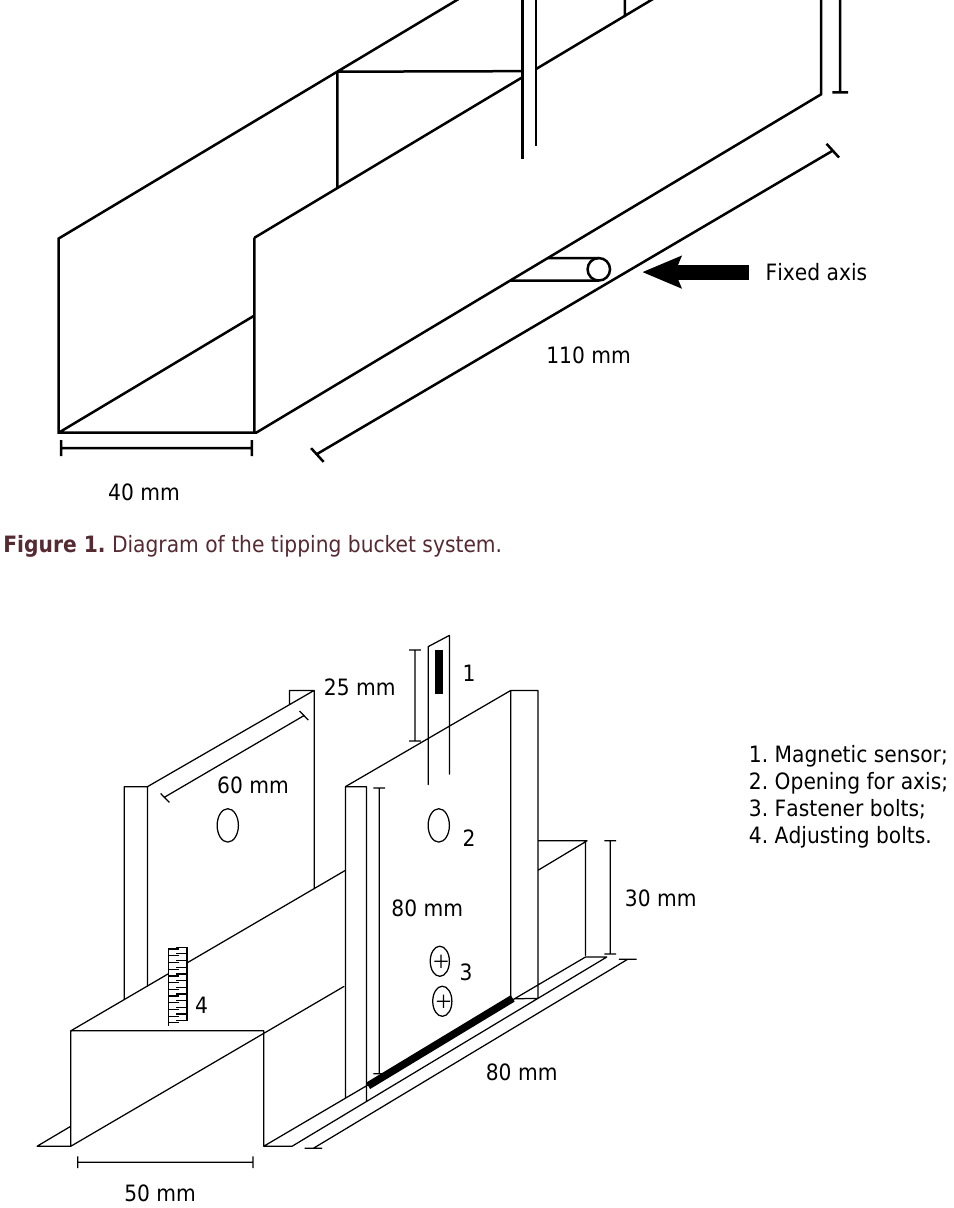
Figure 2. Diagram of the metal base used to support the tipping bucket